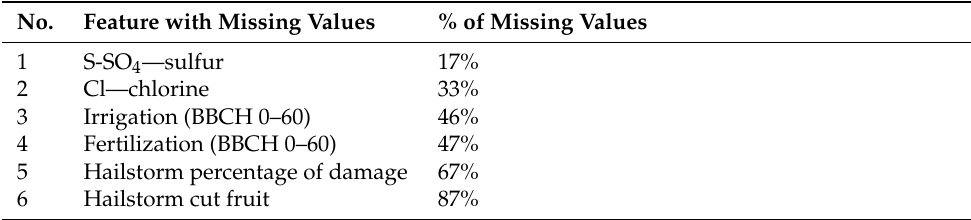
Table 4. List of features with missing